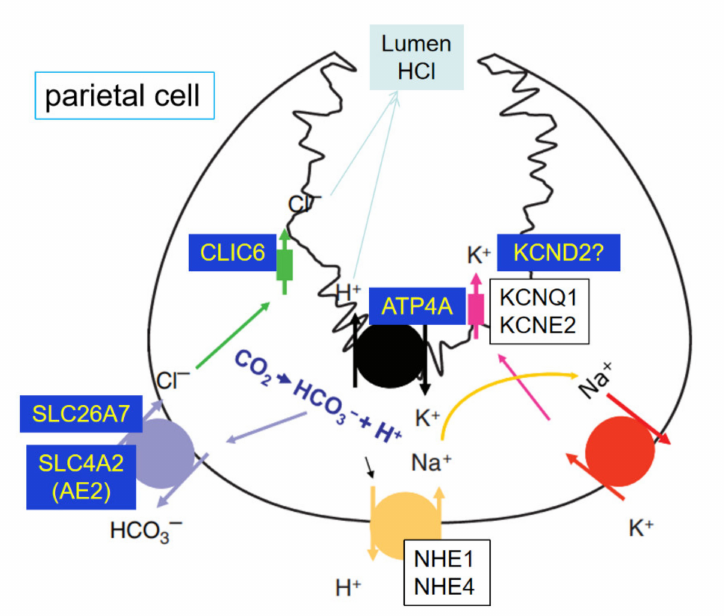
Figure 5. Ion transporters involved in hydrochloric acid (HCl) output of the parietal cell. ATP4A, KCND2, SLC26A7, SLC4A2 and CLIC6 were the DEGs in